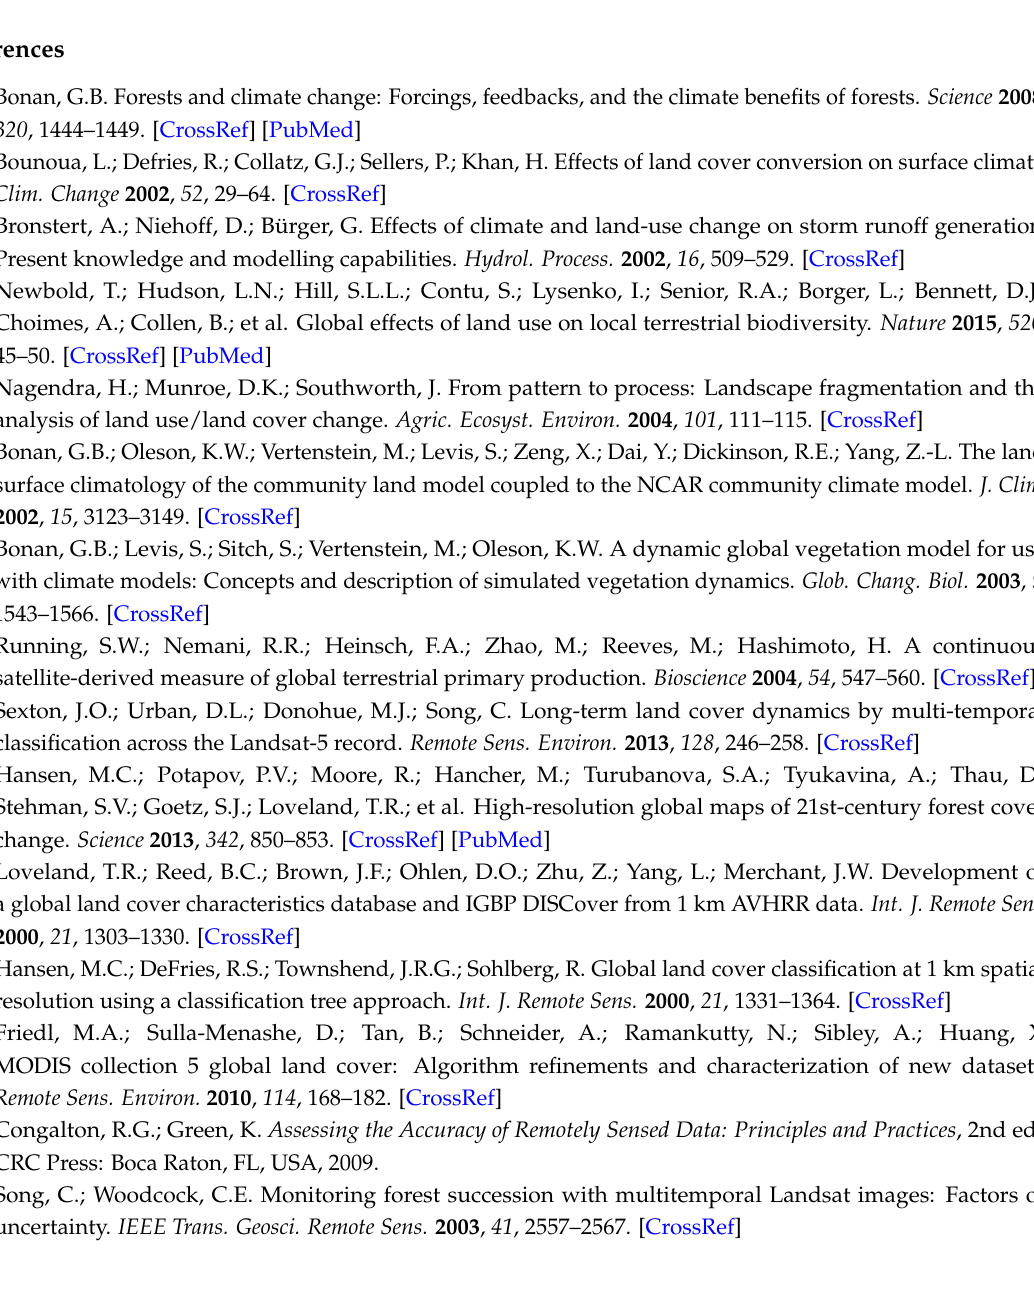
Table S1: Comparison of 2006 NLCD to 2006 AASG1, Table S2: Comparison of 2006 NLCD to AASG2, Table S3: Comparison of 2011 NLCD to 2011 AASG1, Table S4: Comparison of 2011 NLCD to 2011 AASG2, Table S5: Overall agreement for different combinations of AASG data and methodology in 2006, Table S6: Overall agreement for different combinations of AASG data and methodology in